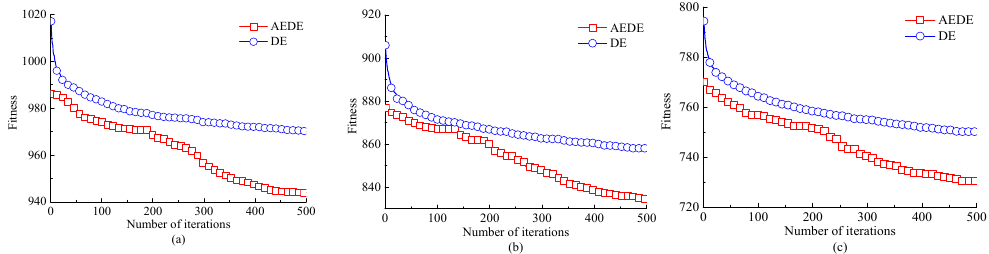
Figure 6. Convergence curve of differential evolution algorithm ( a ) Comparison of convergence under rectangular distribution of peach trees; ( b ) Comparison of convergence under trapezoidal distribution of peach trees; ( c ) Comparison of convergence under irregular distribution of peach trees.